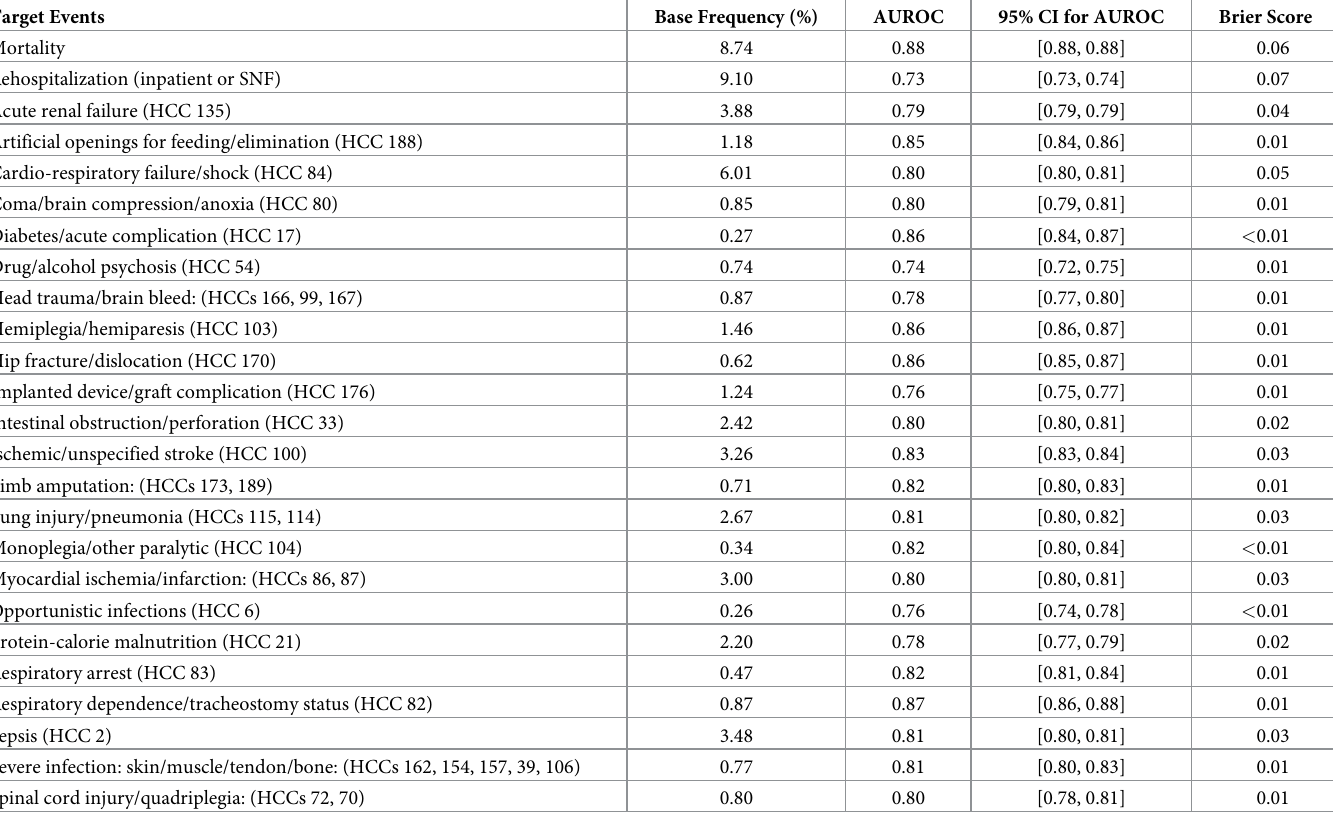
Table 1. Results of prediction